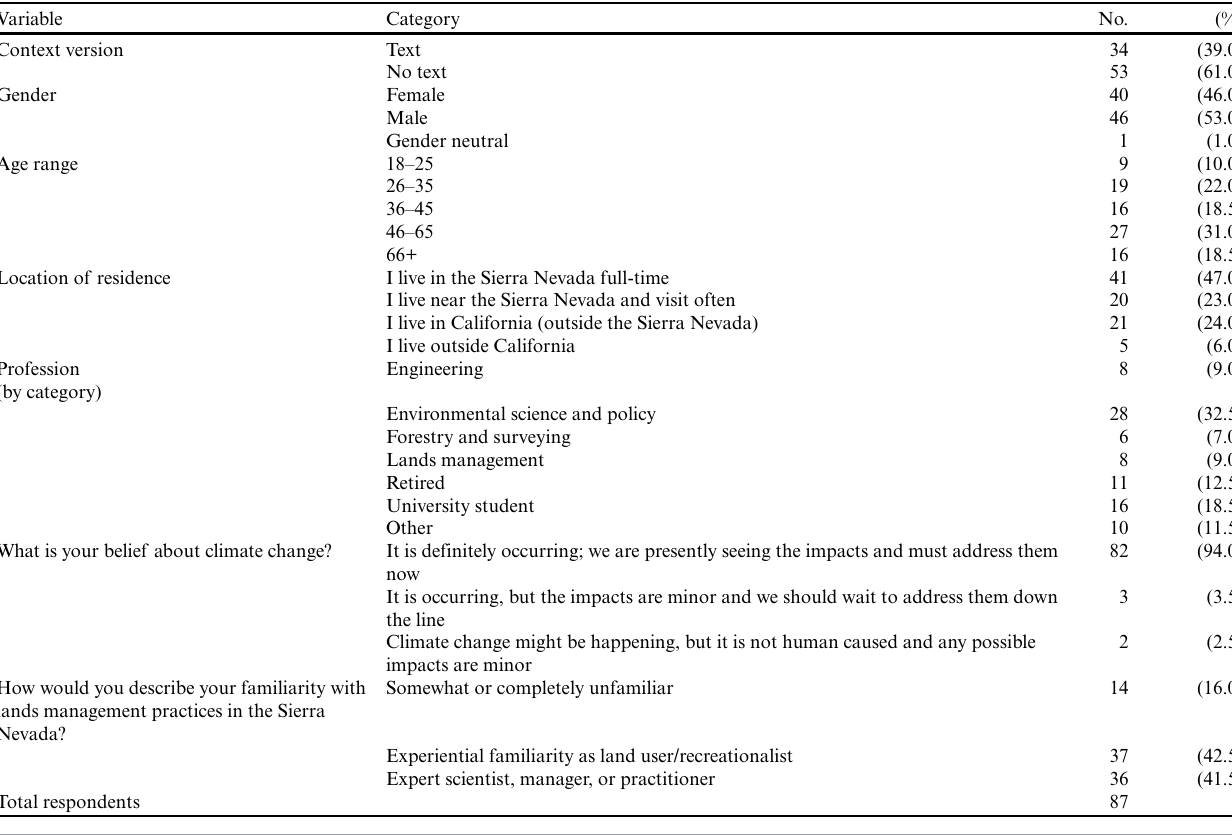
Table 2 . Respondent